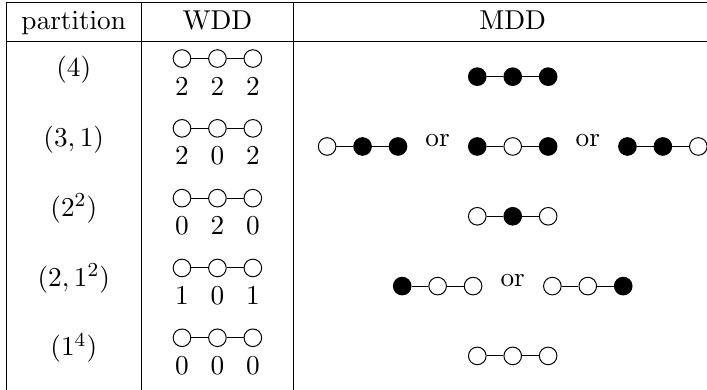
Table 11 . Nilpotent orbits of A 3 can be labelled by partitions or weighted Dynkin diagrams. The corresponding parabolic subalgebras can be encoded in marked Dynkin